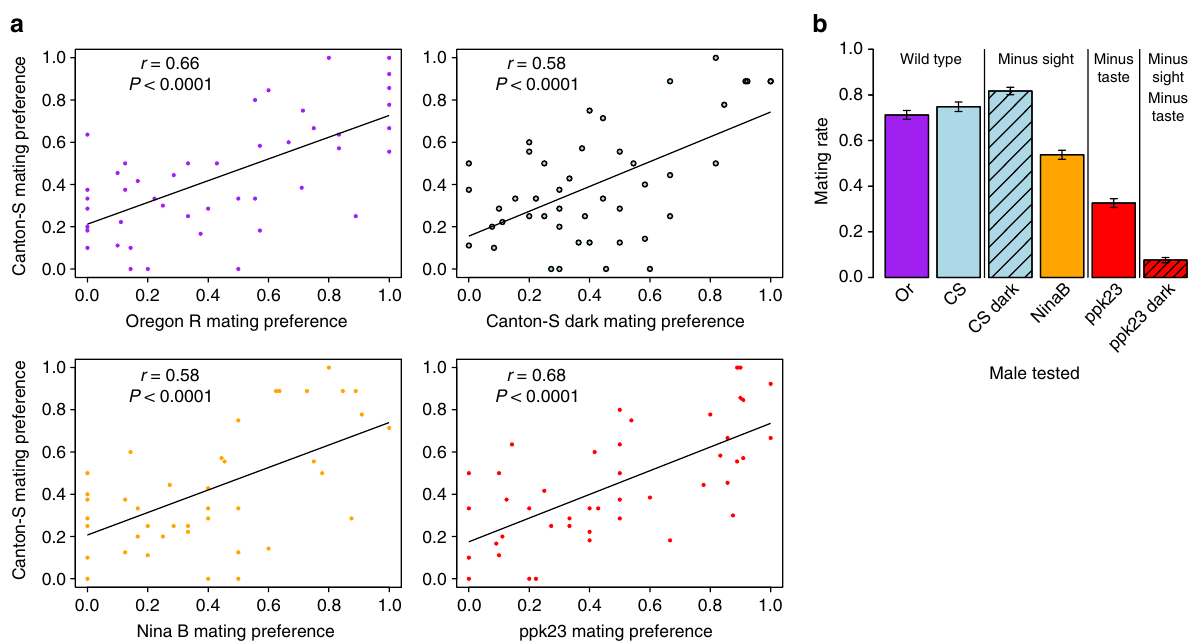
Figure 2 | Males with impaired signal detection make similar mate choices. ( a ) Correlation of the proportion of the first female line mated for all 45 pairwise combinations of 10 DGRP female lines between Canton-S males and Oregon-R (wild type), Canton-S males in the dark (blind), ninaB (cid:2) / (cid:2) mutant males (blind) and ppk23 (cid:2) / (cid:2) mutant males (deficient CHC detection). Regression lines represent geometric mean regression. The significance of Pearson’s correlation coefficients were calculated via 10,000 permutations of the data (see Methods for details). ( b ) Mating rates for all males tested ( ± s.e.m.). Bar colour represents genetic background (purple ¼ Oregon-R, blue ¼ Canton-S, orange ¼ ninaB (cid:2) / (cid:2) , red ¼ ppk23 (cid:2) / (cid:2) ), whereas black hashmarks signify that mating trials were conducted in the dark.